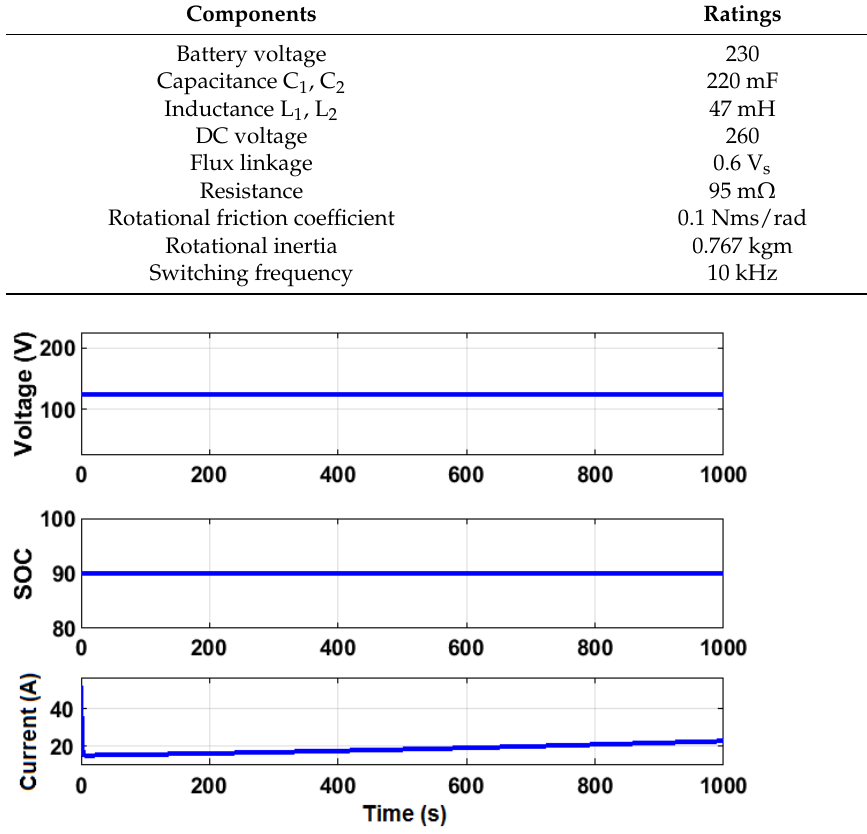
Figure 5. Performance analysis of voltage, SOC, and current waveforms for the Neural Network–Improved Particle Swarm Optimization (NN–IPSO) controller.